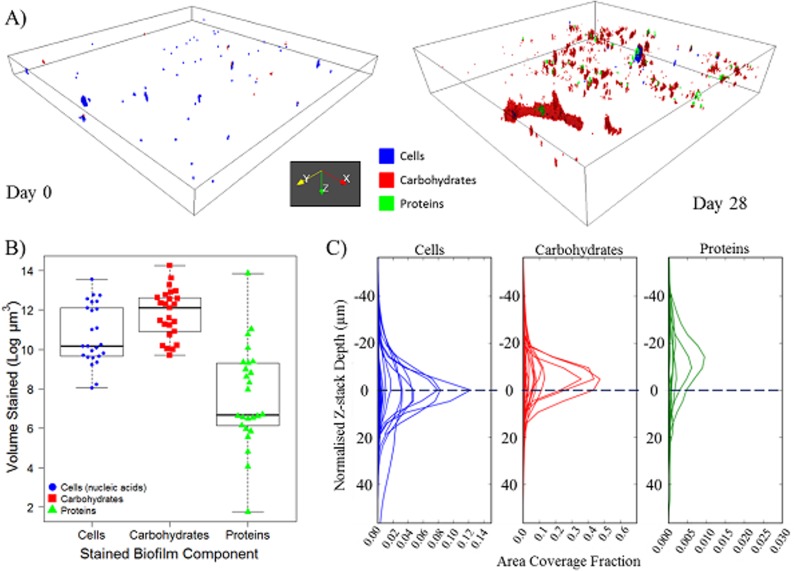
An example of the arrangement, volume and distribution of cells, carbohydrates and proteins of drinking water biofilms.A) 3D projection of example Day 0 and Day 28 biofilms, plotting region shown is 420 μm × 420 μm × 30.6 μm and 420 μm × 420 μm × 94.4 μm, respectively; B) Volume (log) of biofilm components at Day 28, relative to the thresholds used in digital image analysis, each data point (n = 25) represents a FOV, box and whisker plots show the range, interquartile range and median—indicated by the solid black line; C) Day 28 area distribution plot, each line (n = 25) indicates a FOV, note the different x-axis scales between components. Area coverage fraction refers to the proportion of each XY image of the Z-stack covered by the particular component, blue dashed line at “0” indicates the cell peak location; peak location is the aligned slice number at which the maximum area fraction occurs. Area fractions for carbohydrates and proteins are plotted relative to cells (see Materials and Methods for details).